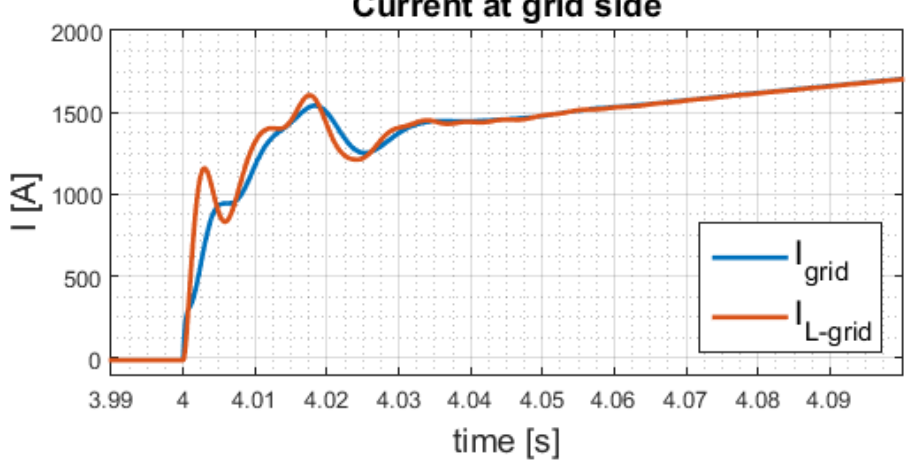
Figure 17. Grid current during EV-side